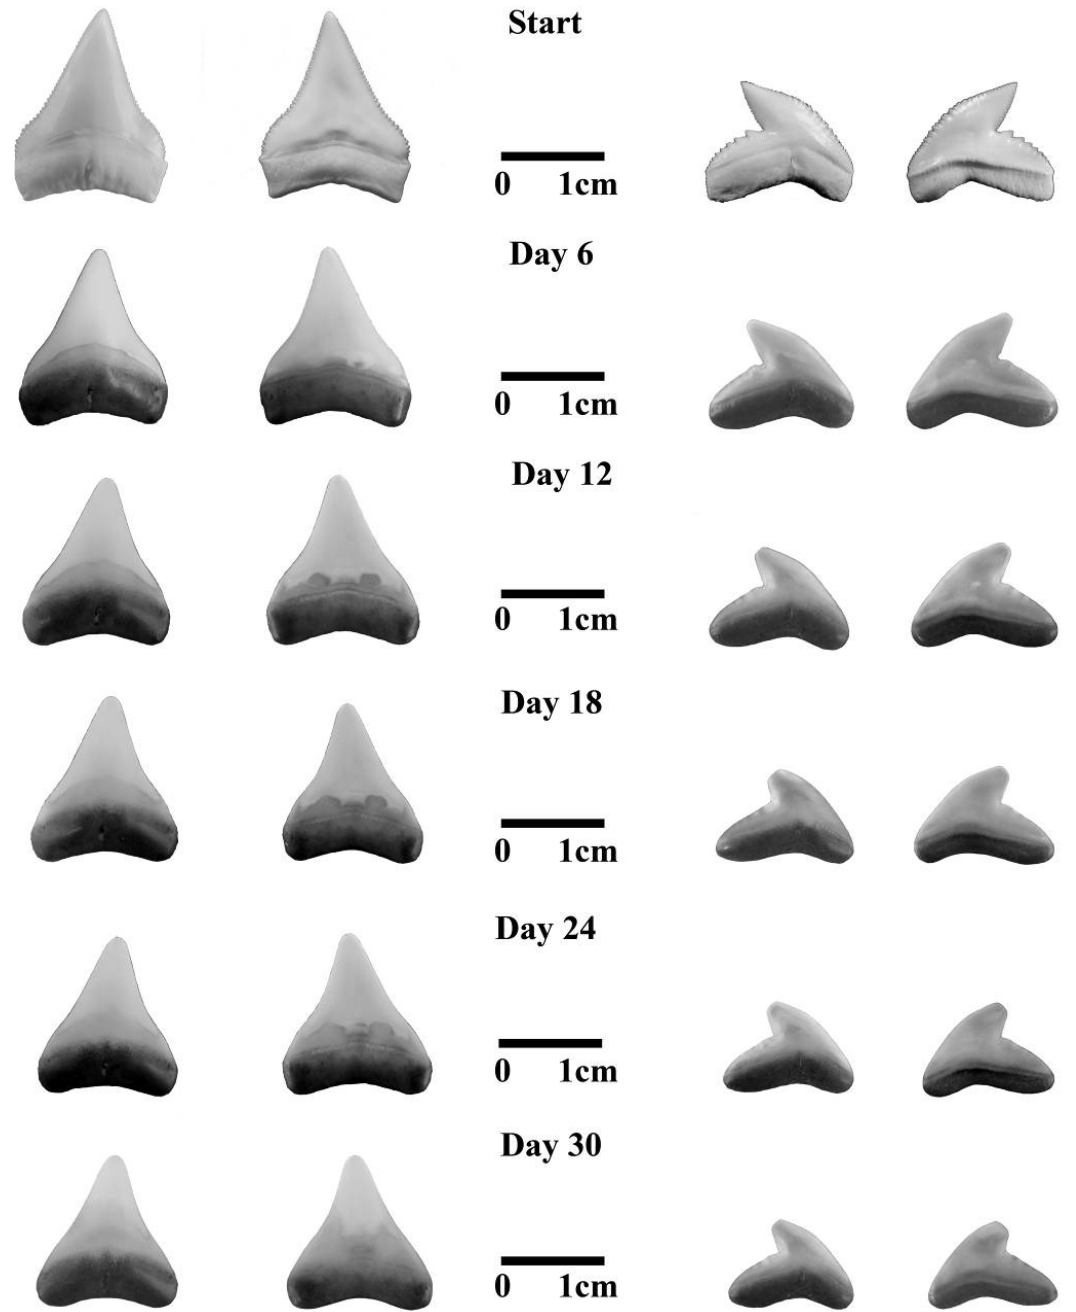
Figure 7. Functional teeth of Carcharhinus leucas ( left two columns) and Galeocerdo cuvier ( right two columns) (lingual and labial views) during one month in an industrial tumbler with 5.0 kg of host sediment from the lowermost Navesink Formation. Individual teeth were removed at six day intervals and photographed. All scale bars =1.0 cm. Note iron staining in root and along cusp edges, and physical changes similar to those seen in Figures 5 and